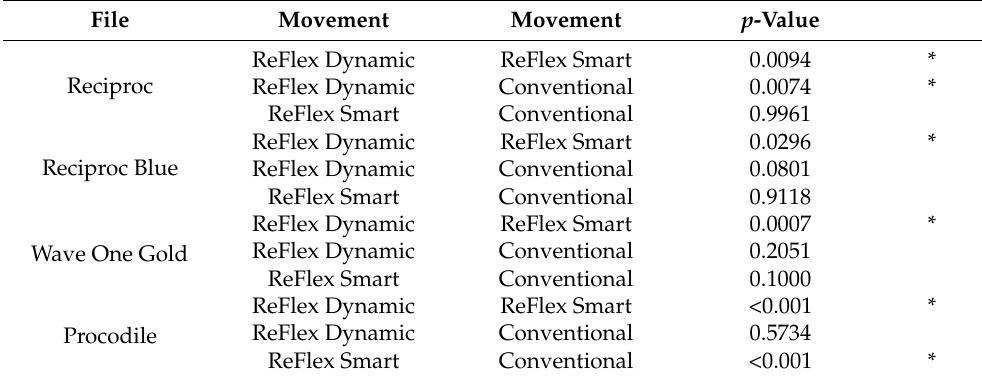
Table 2. Two-to-two comparison between interactions between type of file and movement (* = p value < 0.05). File Movement